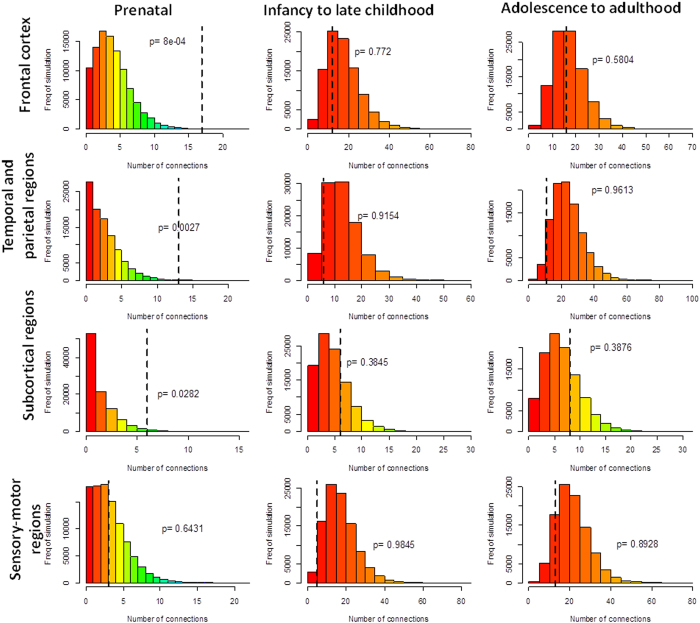
Relatedness of 40 genes in the co-expression network in four brain regions at three developmental stages.We evaluated the co-expression of genes harboring the damaging DNVs in cases and controls using RNA-seq data from the BrainSpan Atlas. Gene pairs were defined as co-expressed if Spearman’s rank correlation coefficient (|R|)> 0.8 for RNA-seq expression levels across different brain areas and a given developmental stage. Networks were created for co-expressed gene pairs as described for Fig. 2. Histograms represent distributions of the numbers of edges in 100,000 simulated networks using genes harboring the damaging DNVs in controls. Dotted lines indicate the numbers of connections (edges) in networks created using genes harboring the damaging DNVs in cases with schizophrenia. The significant enrichment in co-expression of gene mutants in schizophrenia was observed in the frontal cortex and temporal and parietal regions during prenatal development (p < 0.0091 and 0.03 after Bonferroni corrections for multiple comparisons) at prenatal stage. There was no enrichment of co-expression of genes harboring the damaging DNVs at the other stages.